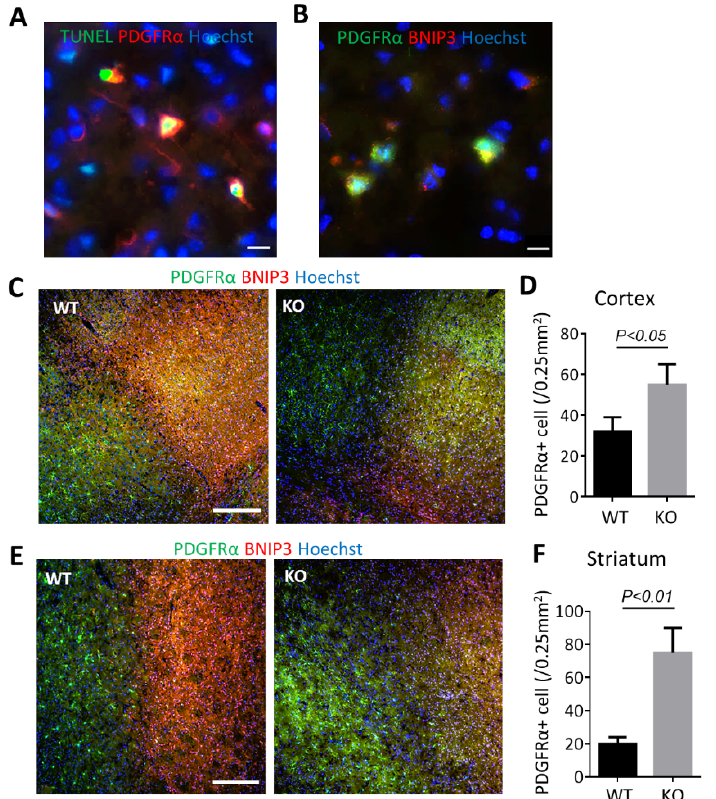
Figure 3. Deficiency of BNIP3 reduces oligodendrocyte death. ( A ) TUNEL assay demonstrated apoptotic cells in ischemic brain were co-labeled with PDGFR α . Bar, 10 µ m. ( B ) Double immunohistochemical staining demonstrated PDGFR- α cells were co-labeled with BNIP3. Images were taken from the external capsule (EC) region. Bar, 10 µ m. ( C ) Double immunohistochemical staining of PDGFR- α and BNIP3 in the ischemic cortex at 7 days after MCAO. Bar, 100 µ m. ( D ) Quantification showed the number of PDGFR- α positive OPCs was significantly higher in the cortex of BNIP3 KO mice than in the wild-type mice. ( E ) Double immunohistochemical staining of PDGFR- α and BNIP3 in the ischemic cortex at 7 days after MCAO. Bar, 100 µ m ( F ) Quantification showed the number of PDGFR- α positive OPCs was significantly higher in the striatum of BNIP3 KO mice than in the wild-type mice. Results shown represent mean ± SD., n = 4.